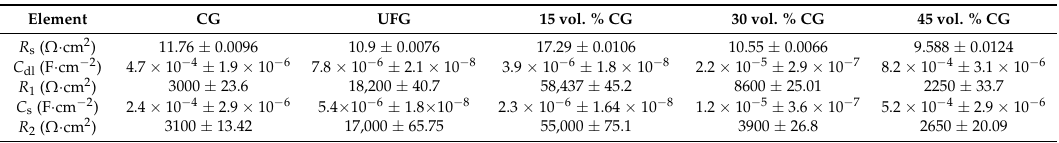
Table 2. EIS parameters obtained by fitting the Nyquist plots (Figure 5a) with the equivalent circuit shown in Figure